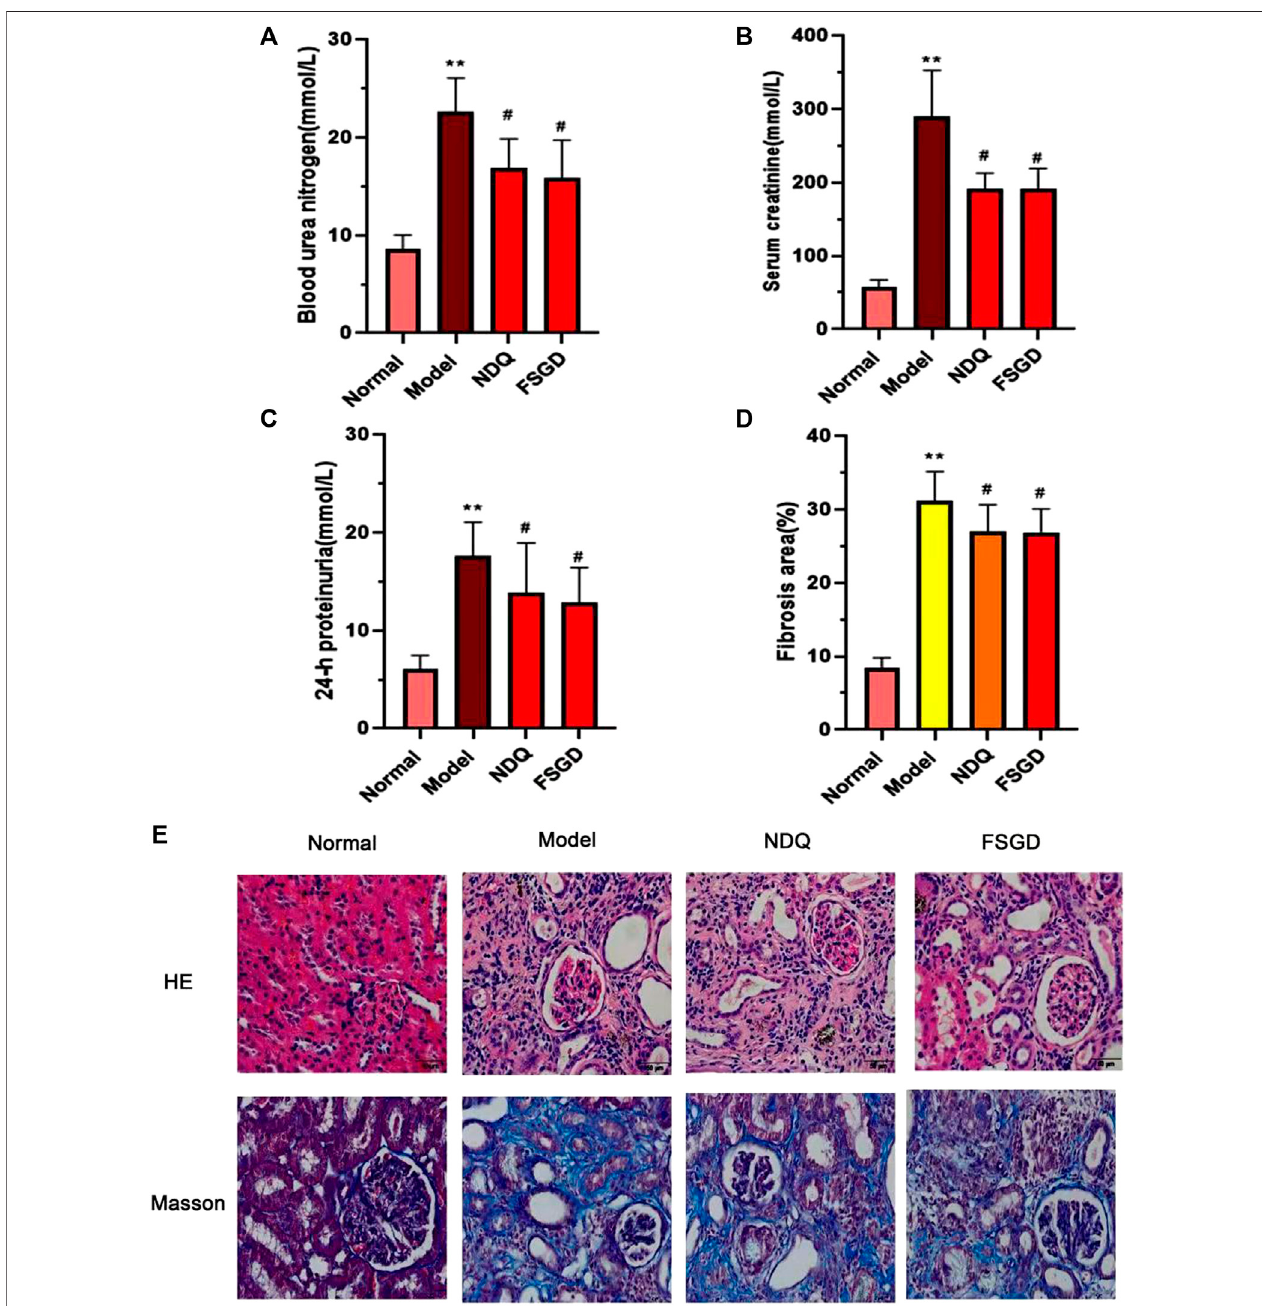
FIGURE5| EffectsofFSGDonrenalpathologicalinjuryandrenal fi brosis. (A – C) EffectsofFSGDonserumconcentrationsofBUNCRand24-hurinaryprotein. (D) Renal pathological changes were analyzed by hematoxylin-eosin and Masson staining was used to analyze collagen fi bers in the kidney (×400). (E) The collagen fi bers deposition wasstatistically analyzed with ImageJ software. The data are expressed as: compared with the normal group; Data were presented asthe means ± SD. * p < 0.05, ** p < 0.01; versus normal group; ## p < 0.01, # p < 0.05, compared with the model group, respectively.